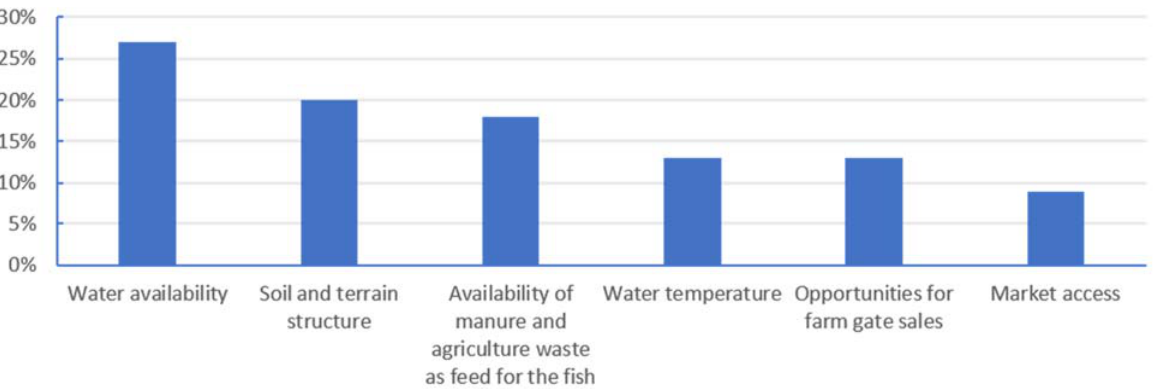
Figure 4. The relative importance of factors influencing on fish pond farming as ranked by 16 regional fisheries officers in Tanzania.